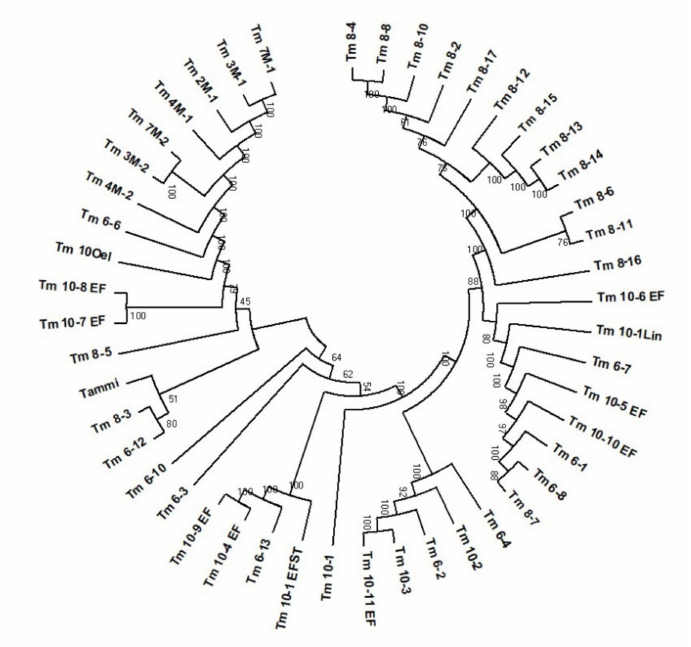
Figure 4. Neighbor-joining dendrograms based on pairwise distance matrix representing the group- ing of the 46 rapeseed mutant lines and original cultivar obtained from 35,397 union SNPs from GBS. The results of the flowering times, crude fat contents, and fatty acid compositions hierarchical cluster analysis are presented in Figure 5. The original cultivar and the 46 mutant lines were clustered into 10 groups and one independent group. Group I contained four late, three intermediate, and one early flowering time lines with oleic acid contents ranging from 68.4% to 70.7%. Group II consisted of the original cultivar and four mutant lines with oleic acid contents ranging from 64.9% to 67.4%. Group III included three mutants with high oleic and erucic acid contents. Group IV contained two mutant lines with high crude fat and linoleic acid contents. Group V had five mutant lines with low crude fat and high oleic acid contents. Group VI possessed six mutant lines with low oleic acid and high palmitic, linoleic acid, and linolenic acid contents. Group VII consisted of two mutant lines with low oleic acid and high crude fat contents. Seven mutant lines showing high linoleic acid and intermediate crude fat contents belonged to Group VIII. Group IX contained five mutant lines with low crude fat and intermediate oleic and linoleic acid contents. Two mutant lines with low crude fat and high erucic acid contents belonged to Group X. The Tm8-14 line did not belong to any groups. Hierarchical cluster analysis divided flowering time, crude fat content, and six fatty acid compounds into two clusters and two independent groups. Cluster I contained three fatty acid compounds: palmitic, linoleic, and linolenic acid. Cluster II contained stearic acid, crude fat content, and flowering time. Oleic and erucic acid contents formed independent